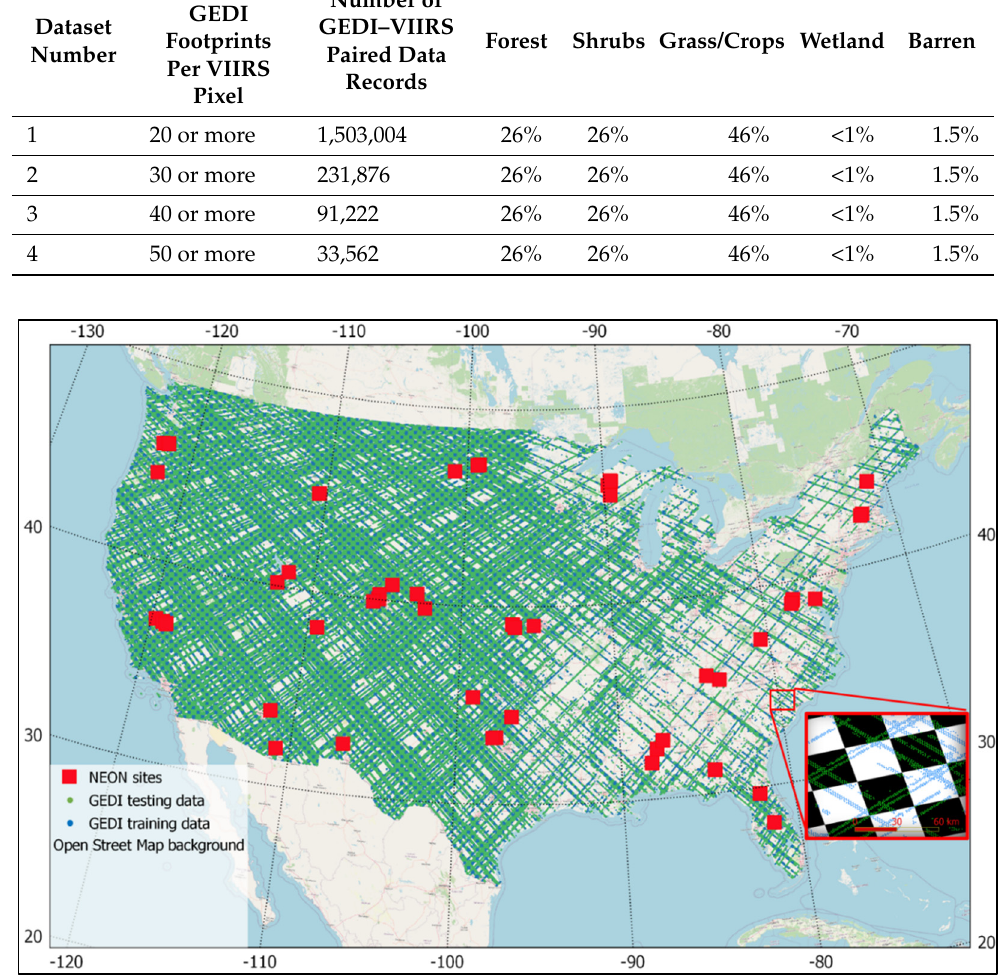
Figure 4. ( a ) The distribution of GEDI − VIIRS paired data records testing and training subset with a cutoff value of 30 or more GEDI footprints per VIIRS pixel, and ( b ) the 25 − kilometer checkerboard used to subset the GEDI–VIIRS paired data records into training (blue points) and testing (green points) subsets.